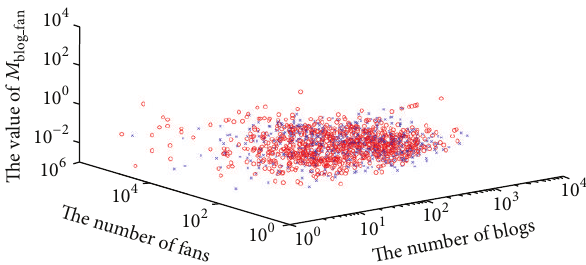
are arranged in top Blog Fan